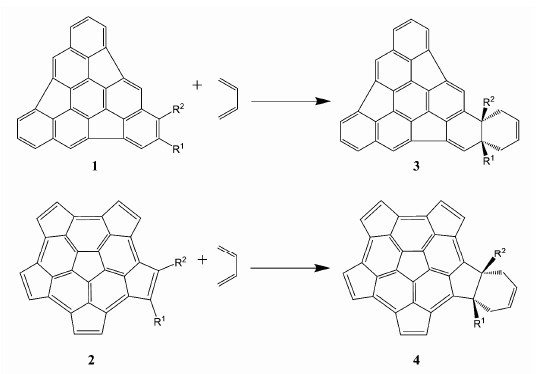
Scheme 1. DA reactions for the substituted fragments 1 ( upper panel ) and 2 ( lower panel